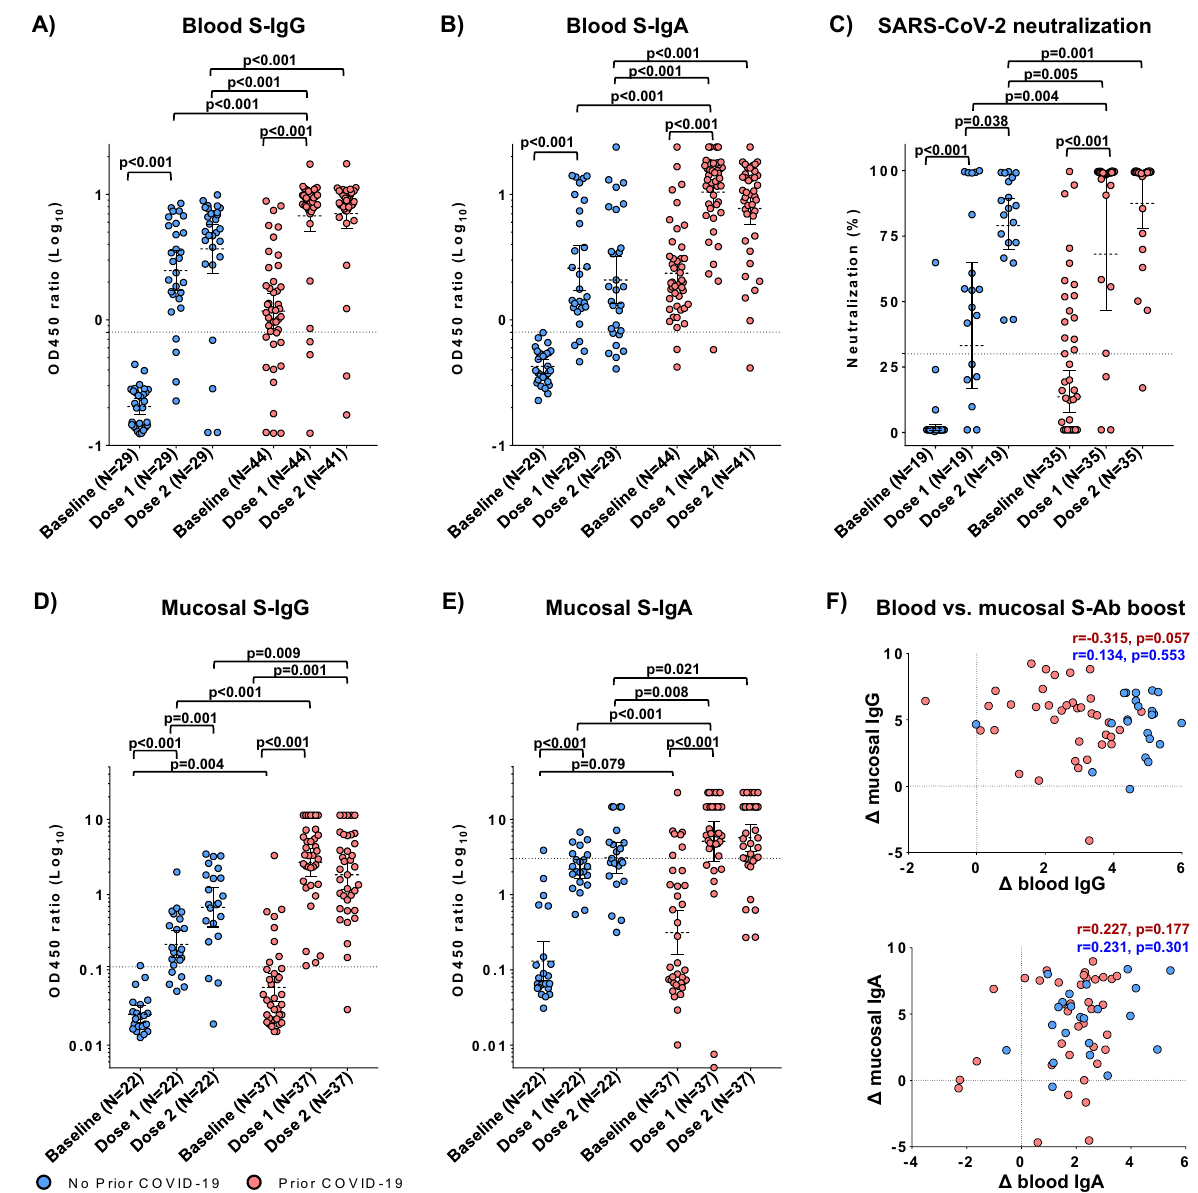
Figure 4. Effects of Sputnik-V vaccination on blood and mucosal SARS-CoV-2 antibodies in participants stratified by prior exposure to COVID-19. ( A ) Blood Spike-reactive IgG titers at baseline and after vaccination. ( B ) Blood Spike-reactive IgA titers at baseline and after vaccination. ( C ) SARS-CoV-2 neutralization at baseline and after vaccination. ( D ) Mucosal Spike-reactive IgG titers at baseline and after vaccination. ( E ) Mucosal Spike- reactive IgA titers at baseline and after vaccination. ( F ) Correlation plots of mucosal and blood IgG (top) and IgA (bottom) log2-transformed post-dose 2/baseline titer ratios (denoted by “ Δ ”). The Spearman coefficients (r) and their statistical significance (p) are shown. In panels A-E: brackets represent geometric means and 95% confidence intervals; p values indicate the statistical significance assessed by the Mann–Whitney U test. In panels A–E: dotted lines represent the thresholds of assay positivity, defined as OD450 ratio = 0.8 for blood S-IgG and S-IgA, SARS-CoV-2 neutralization = 30% and OD450 ratio = 0.11 and 3.03 for mucosal S-IgG and S-IgA,